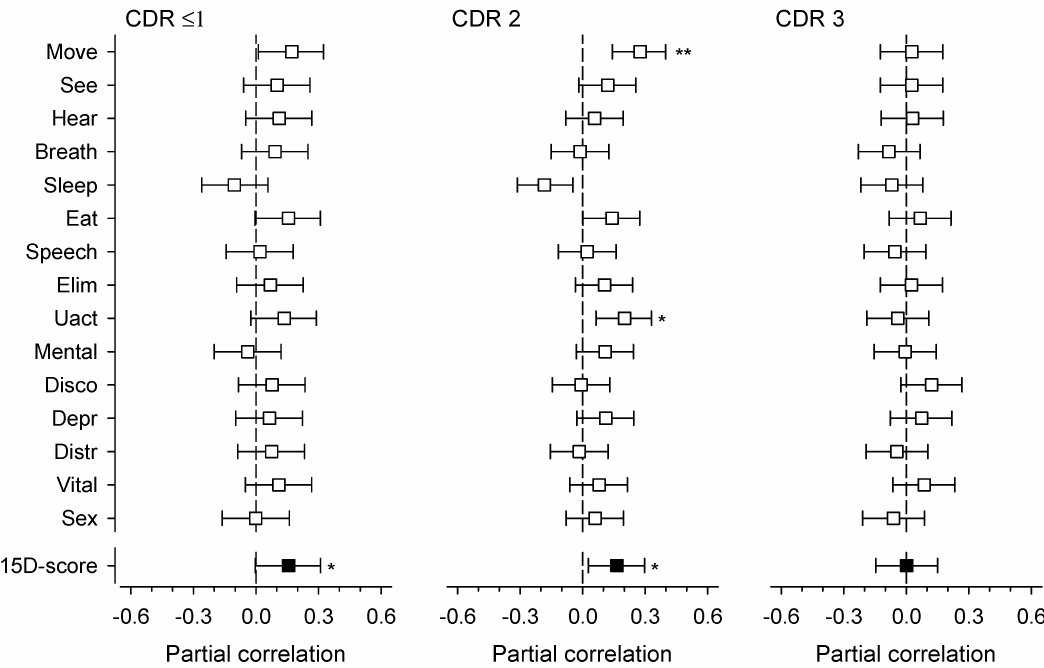
Figure 3. Partial correlations of standardized energy intake per day with health-related quality of life according to 15D [32] at various stages of dementia according to the Clinical Dementia Rating (CDR) [28]. The correlations were adjusted for age, Charlson Comorbidity Index [27], and body mass index. * p < 0.05, ** p <